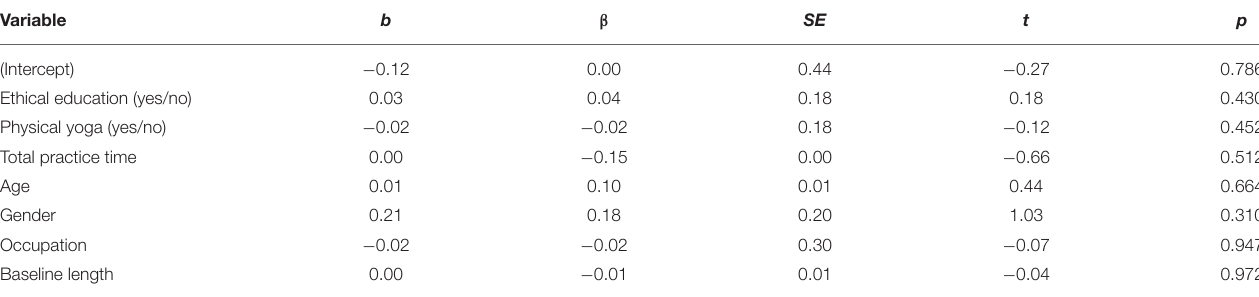
TABLE 6 | Regression model for Tau- U stress estimates as dependent variable and effective component, age, gender, and baseline length as predictors ( df = 36). Variable